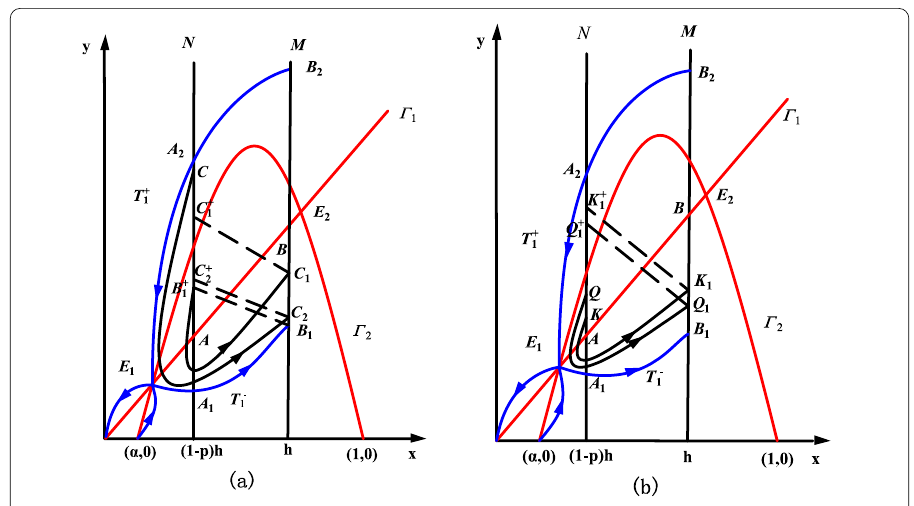
Figure 3 The existence and uniqueness of the order one periodic orbit of system (3) in case I. ( a ) The existence of the order one periodic solution of system (3). ( b ) The uniqueness of the order one periodic orbit of system